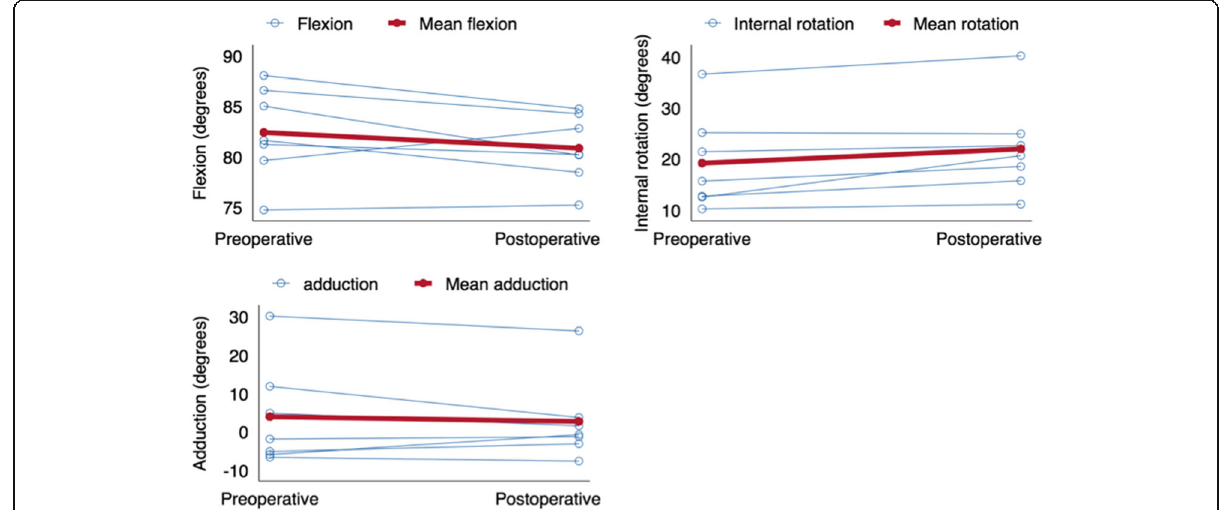
Fig. 6 Scatter plot showing the development in flexion, internal rotation and adduction between the pre- and postoperative